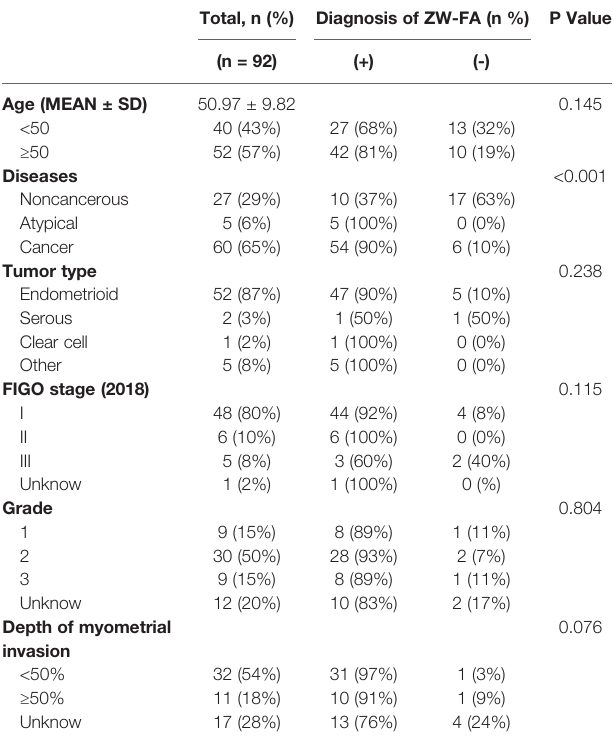
TABLE 1 | Clinical characteristics of patients (N =